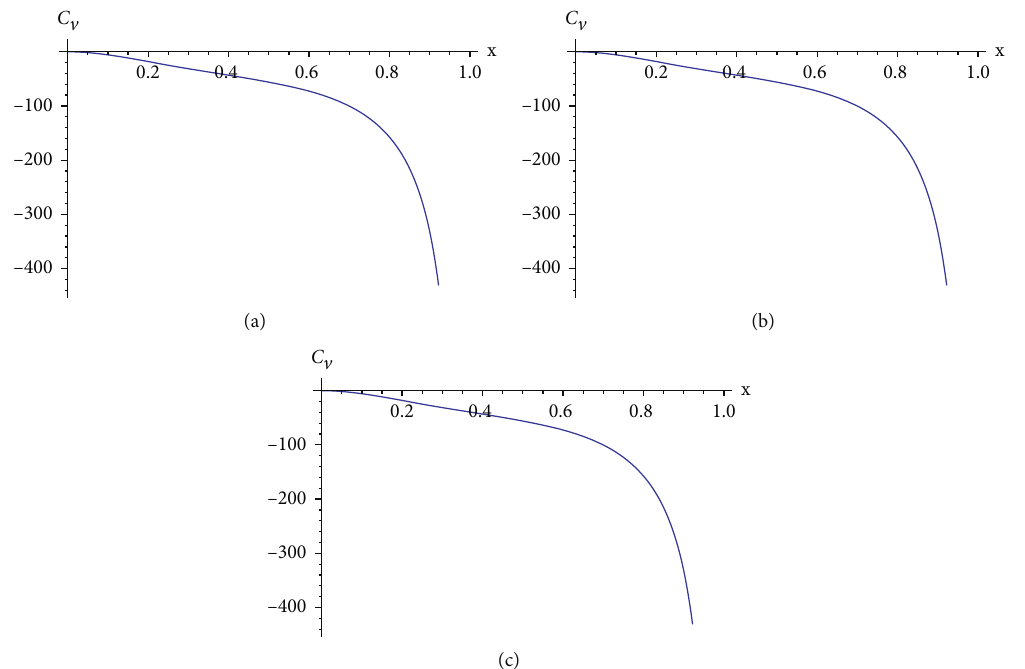
− x curves with l 2 = 100 , and (a) for ϕ 2 V